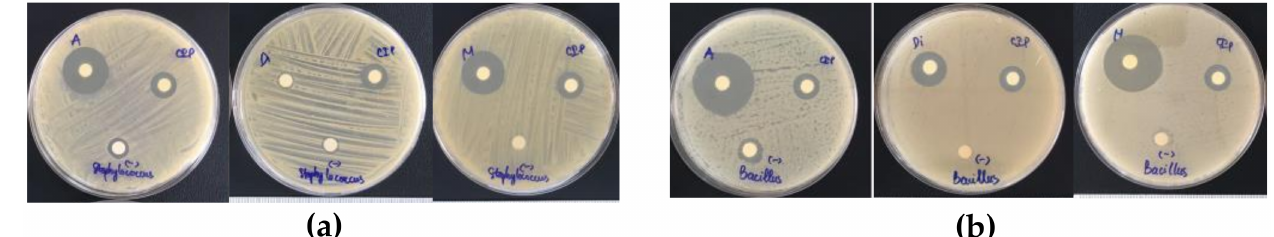
Figure 5. Visual observations of the inhibitory effects of avocado extracts against Gram-positive pathogens including Staphylococcus aureus ATCC 6538 ( a ) and Bacillus cereus ATCC 11778 ( b ). Note: A, Di, M, CIP, and (–) symbols on petri discs denote the acetone, diethyl ether, methanol extracts, ciprofloxacin (reference antibiotics), and negative control,